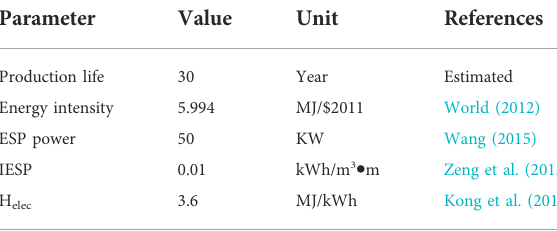
TABLE 2 Key parameters used in DCF-EROI